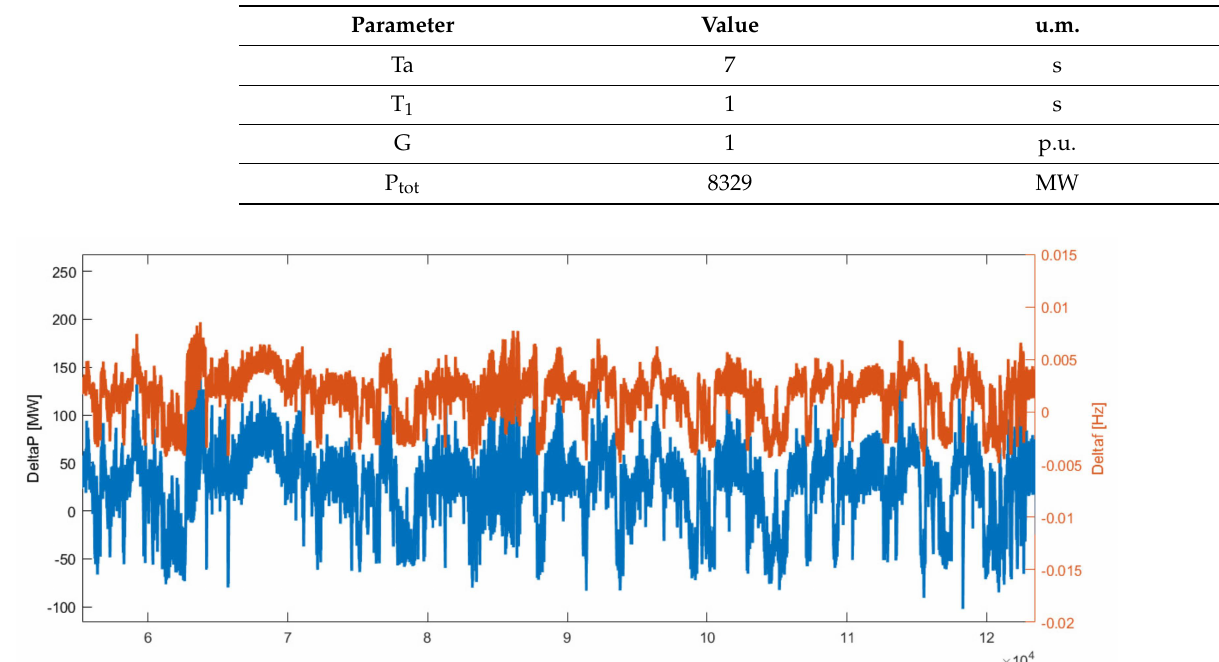
Figure 19. A comparison of the indicators in the different simulations. Table 3. The parameters for the power imbalance estimation.